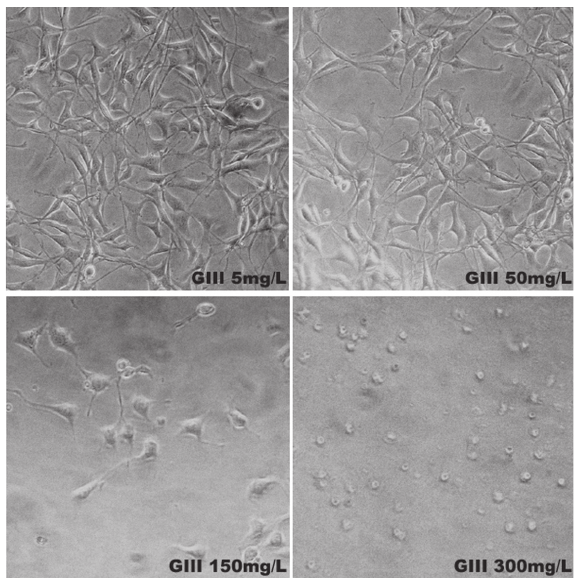
Figure 4- Photomicrographs of Group III (Clyndamicin) at 72 h